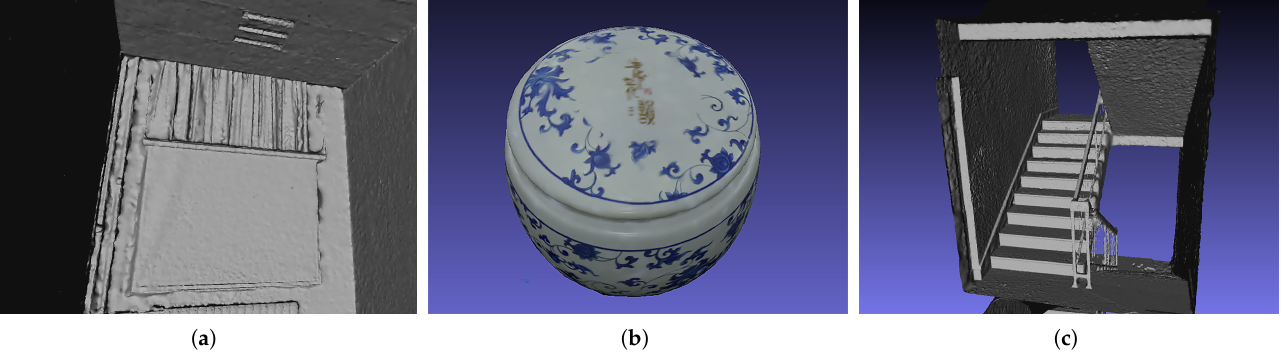
Figure 2. 3D reconstruction results of weak texture scenes. ( a ) Room as shown in Figure 1. ( b ) Teapot. ( c )